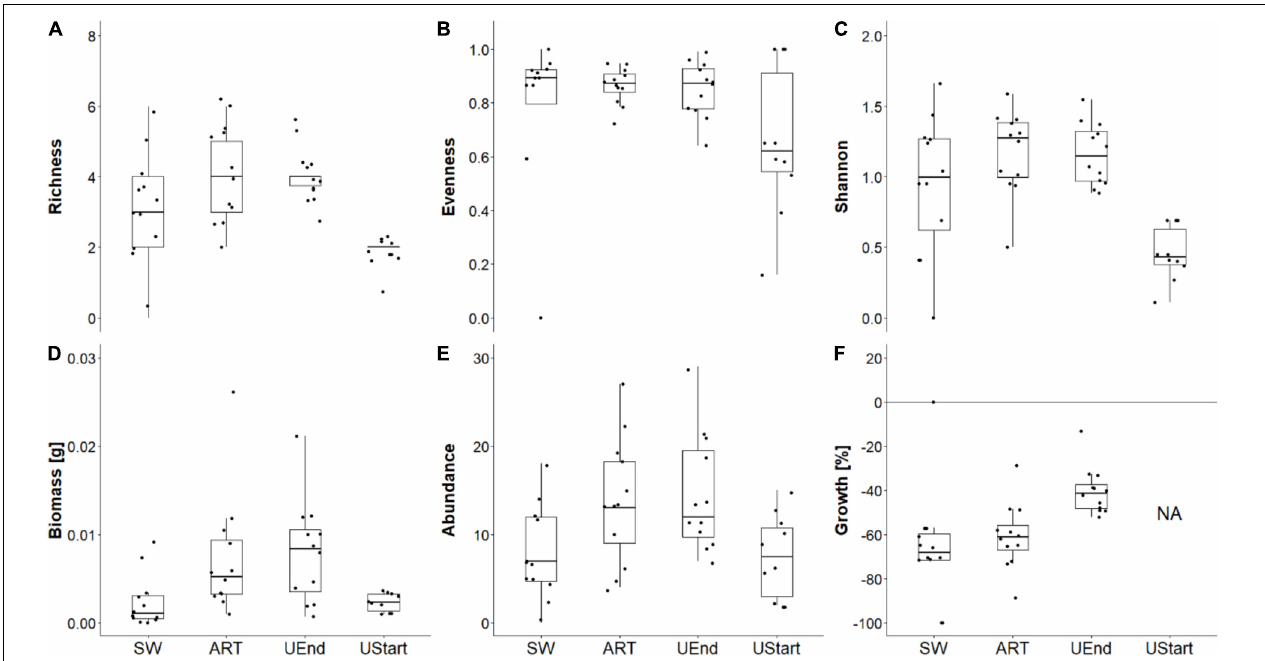
FIGURE 3 | Longyearbyen. Median (thick horizontal line) ± SEM (box), 95% confidence interval (vertical line), and sample-wise values (points) of taxon richness (A) , evenness (B) , Shannon-index (C) , biomass (D) , abundance (E) , and growth (F) of the benthic fauna in core samples (21 cm 2 surface area) taken in seaweed-covered (SW), procedural controls (ART), unmanipulated areas at end (UEnd) and unmanipulated area at start (UStart). For growth, “NA” = data not available for areas unmanipulated at start. n =